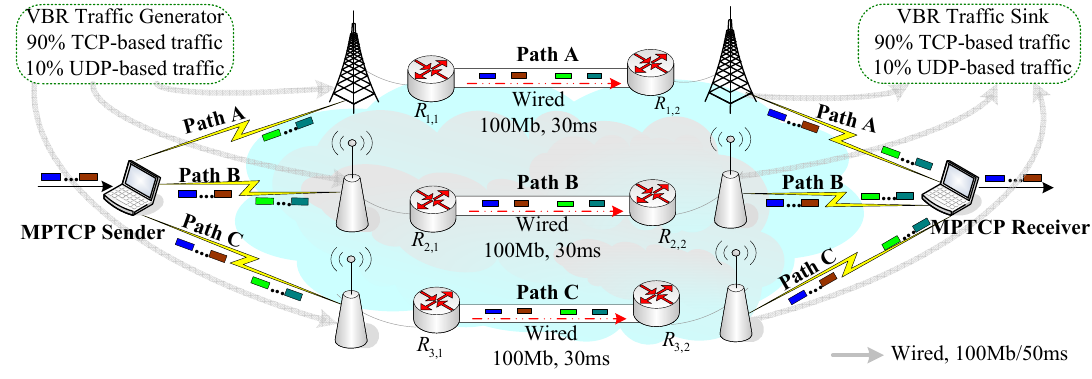
Figure 7. Simulation topology.